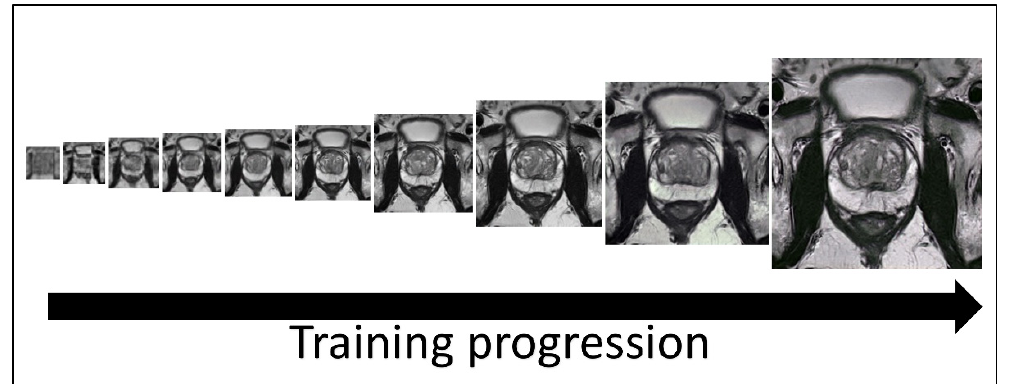
Figure 1. Image generation using SinGAN. SinGAN trains a model using generative adversarial networks in a course-to-fine manner. At each scale, the generator makes sample images that cannot be distinguished in down-sampled training images by the discriminator. The 8th, 9th, and 10th scale images (the three rightmost images) of the model were resized and used in all quality control tests.